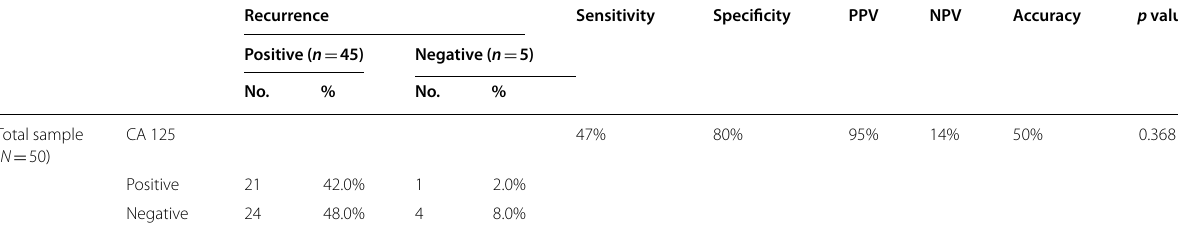
Table 3 Diagnostic performance of serum CA 125 level in OC